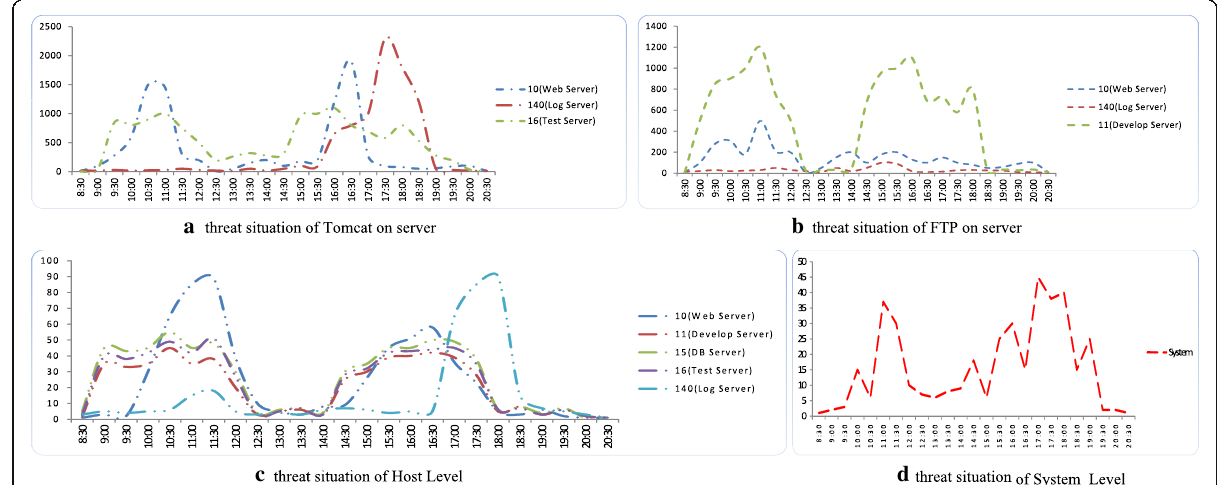
Fig. 5 Hierarchical security situational awareness results of experimental network. a Threat situation of Tomcat on server. b Threat situation of FTP on server. c Threat situation of host level. d Threat situation of system